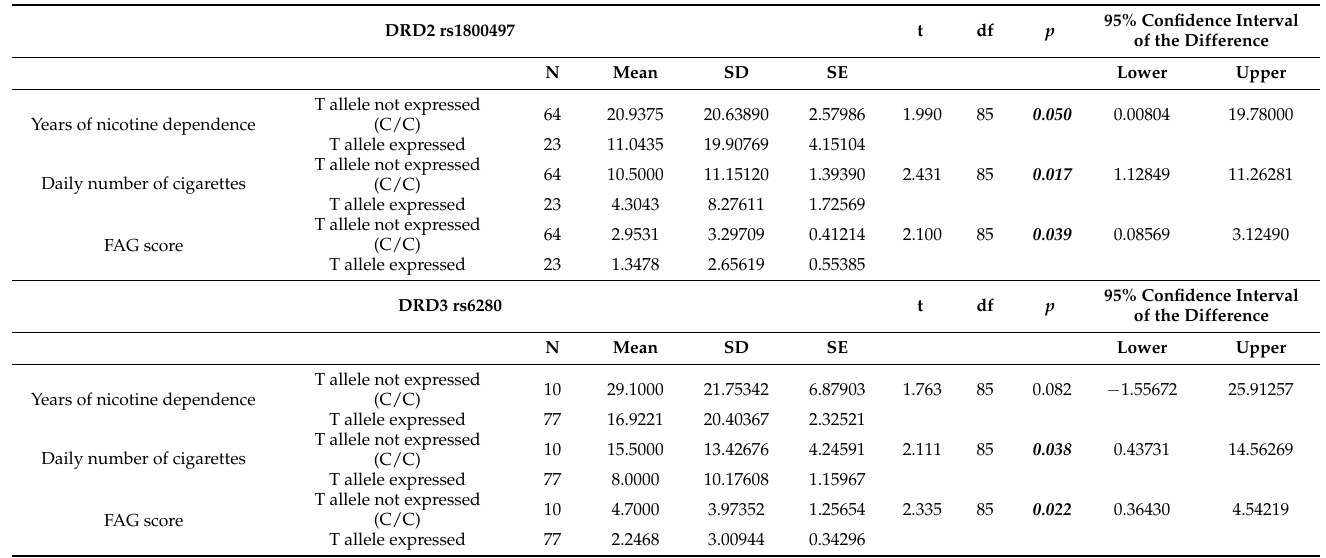
Table 2. Between-genotype comparison of nicotine dependence-related variables (significant